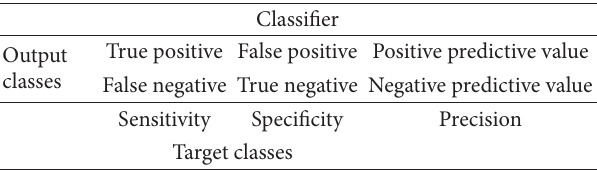
Table 1: Confusion matrix: description of